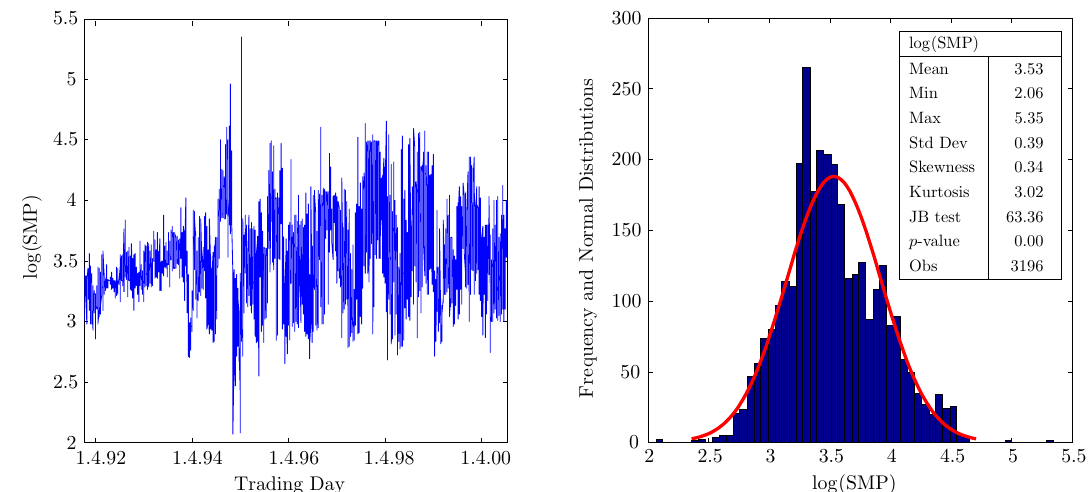
Figure 7. Log of SMP during the peak-demand period over trading days (1 January 1992– 30 September